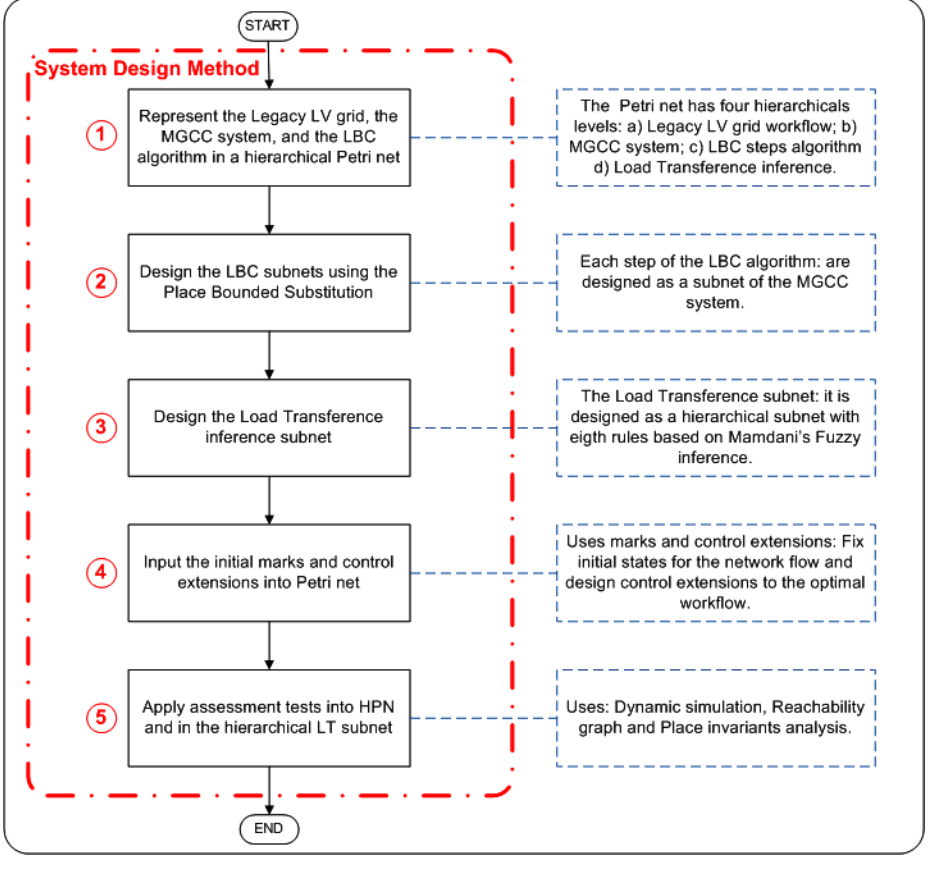
Figure 6. Flowchart describing the system design